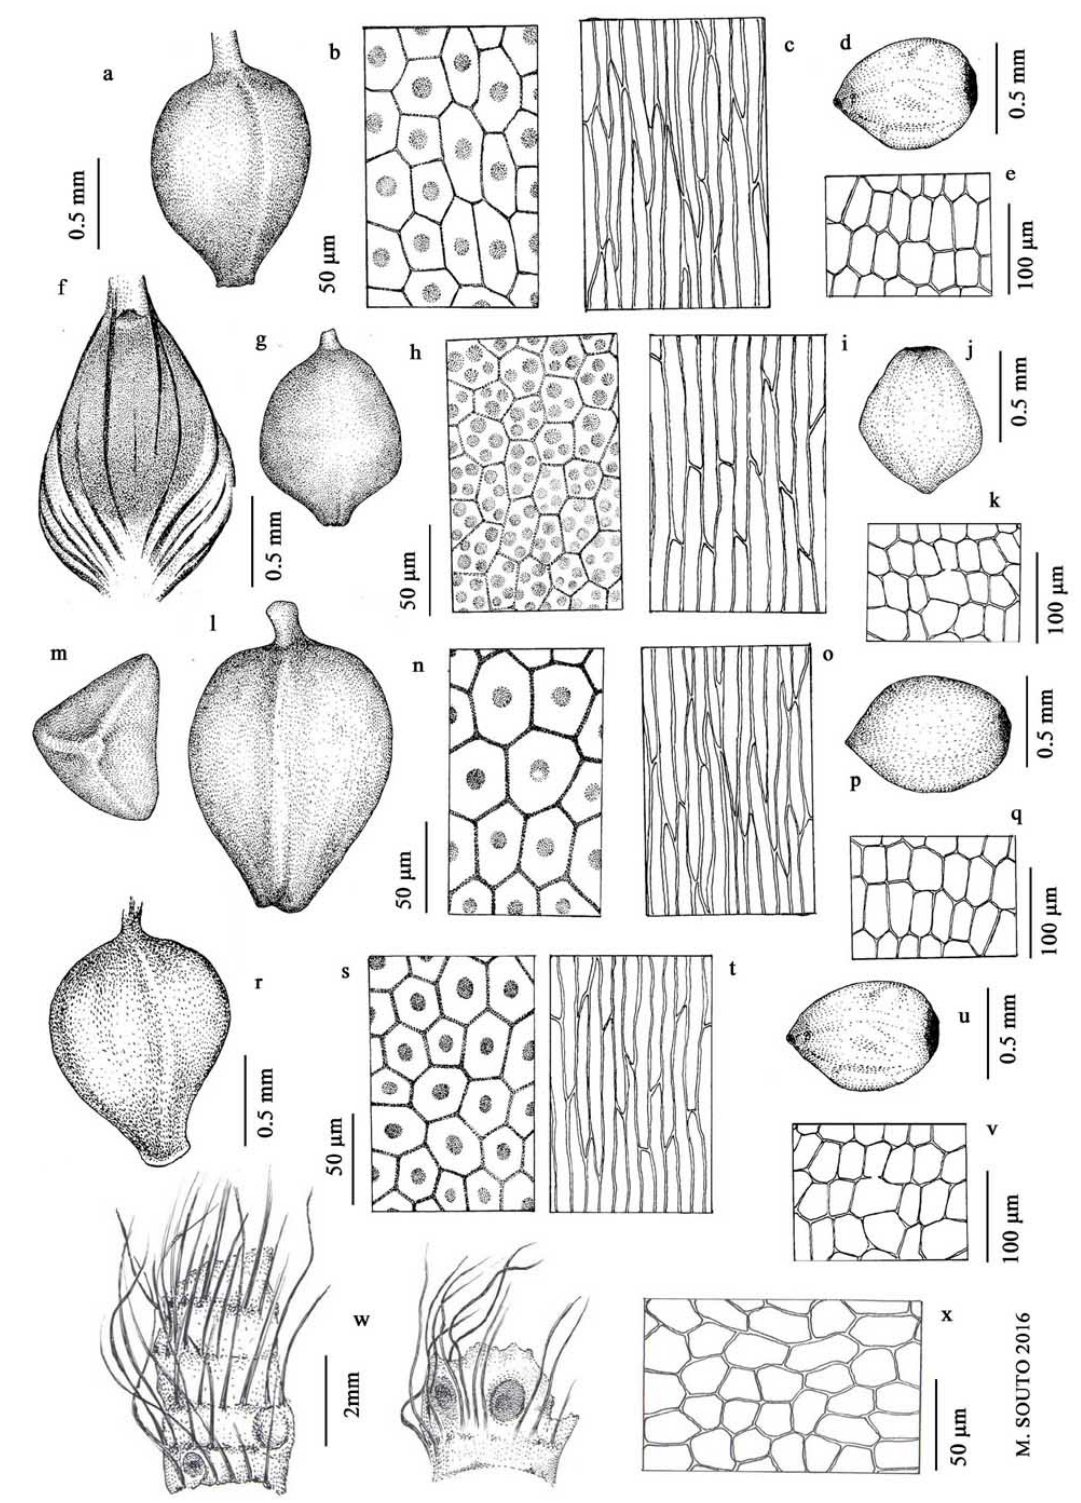
Figure A2. Carex durieui : a) achene; b) outer achene epidermal cells; c) inner achene epidermal cells; d) seed; e) seed testa epidermal cells. Carex echinata : f) utricule; g) achene; h) outer achene epidermal cells; i) inner achene epidermal cells; j) seed; k) seed testa epidermal cells. Carex binervis : l) achene lateral view; m) achene apical view; n) outer achene epidermal cells; o) inner achene epidermal cells; p) seed; q) seed testa epidermal cells. Carex demissa : r) achene; s) outer achene epidermal cells; t) inner achene epidermal cells; u) seed; v) seed testa epidermal cells. Carex spp.: w) rhizome fragments with root scars and remains of leaves; x) rhizome epidermal